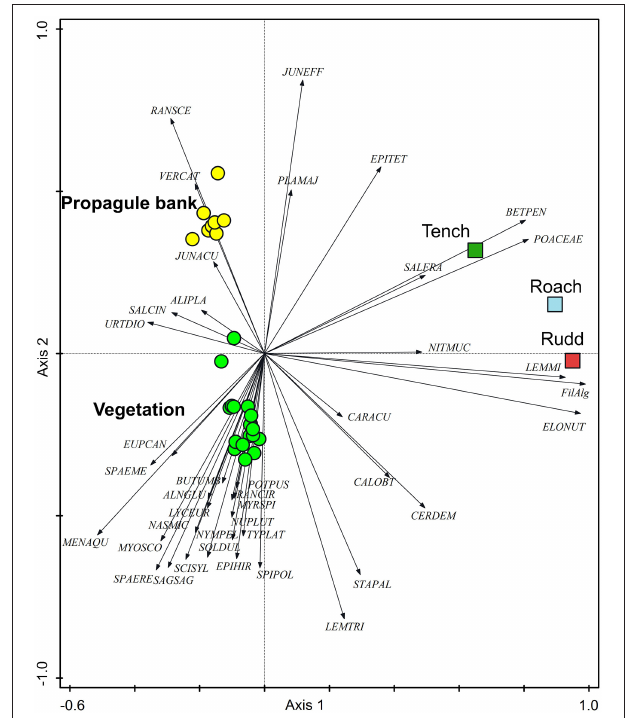
FIGURE 3 | PCoA-diagram for the first two axes, showing the relative positions of vegetation (green) and propagule bank (yellow) samples, of the main plant species (arrows) and of the samples with total number of plant parts found in feces of each fish species (squares). Eigenvalues and explained variation of axis 1 and 2 are 0.357 and 35.7%, and 19.5 and 19.5%, respectively. Abbreviations of species names: first three letters of the genus name, followed by the first three letters of the species name (for full names see Table S2